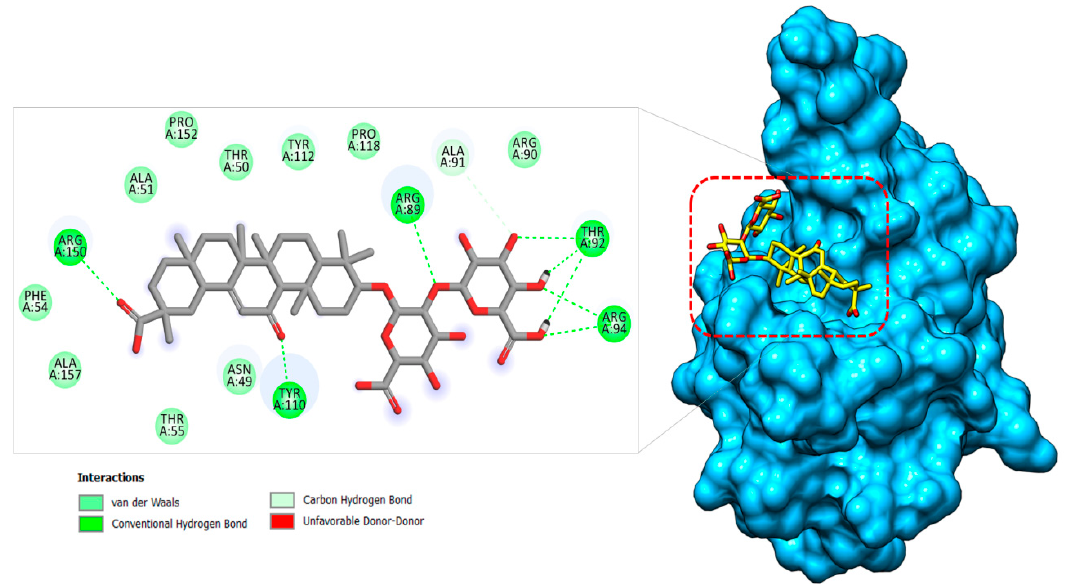
Figure 6. Binding pose of glycyrrhizin (in yellow stick) at the junction binding pocket of PLpro (in deep sky blue surface). A 2D illustration of the glycyrrhizin chemical interactions at the docked site is also provided.